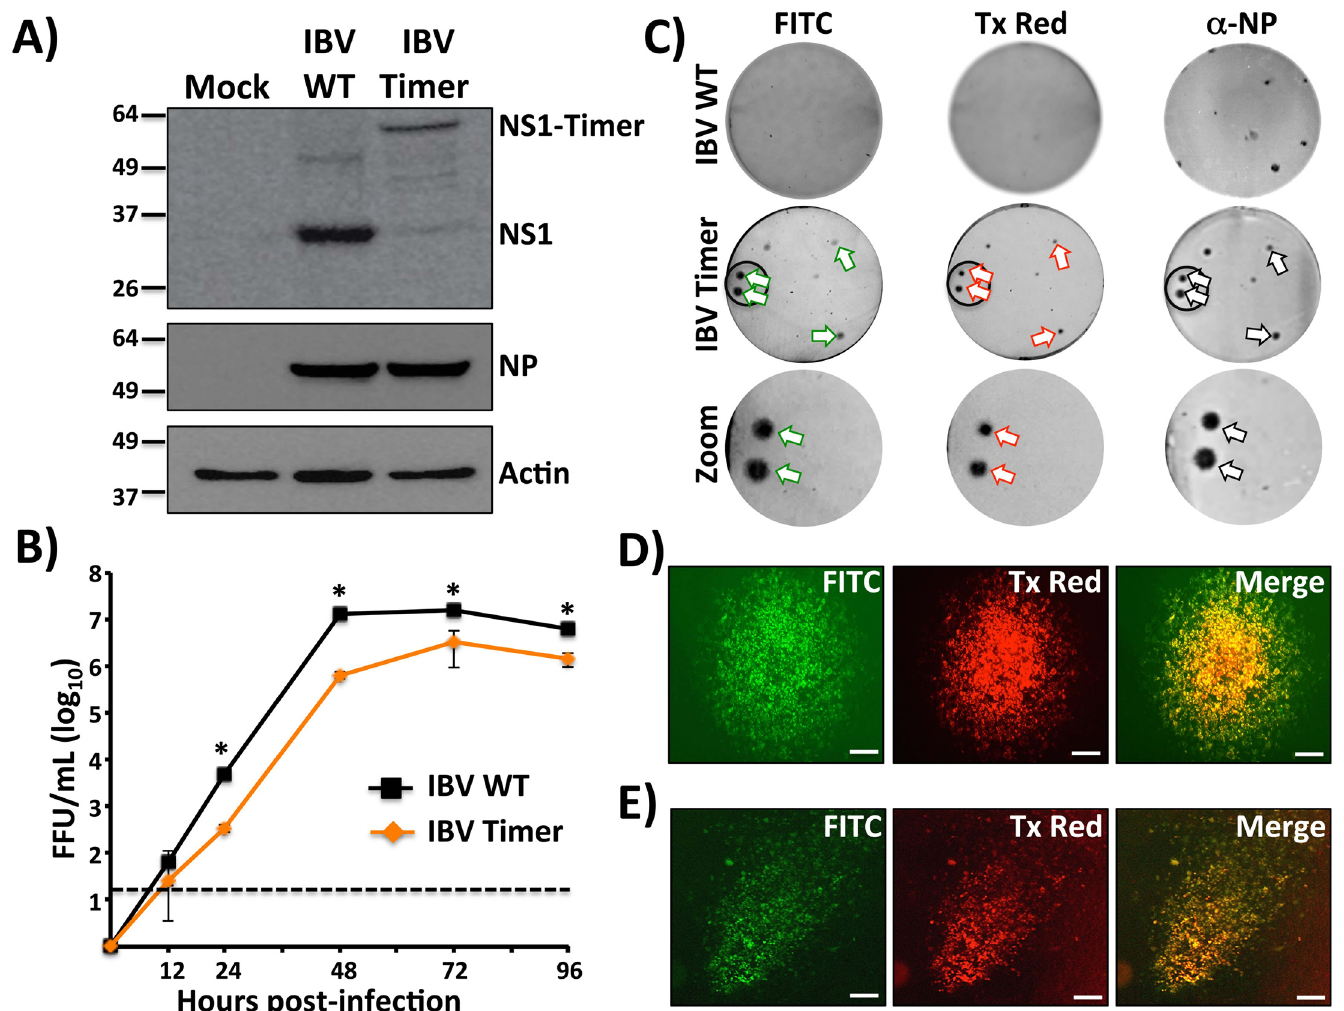
Fig 3. Characterization of IBV-Timer. A) Analysis of protein expression by Western blot: MDCK cells were mock infected or infected (MOI 3) with WT or Timer-expressing IBVs. At 24 hpi, cell extracts were prepared and analyzed for NS1 and NP expression levels using specific antibodies. Actin was used as a loading control. Numbers indicate the size of molecular markers in kDa. B) Multicycle growth kinetics: Viral titers from TCS of MDCK cells infected (MOI 0.001) with WT and Timer-expressing IBV were determined at the indicated times post-infection (0, 12, 24, 48, 72 and 96 hours) by immunofocus assay (FFU/ml). Data represent the means ± SD of the results determined from triplicates. Dotted line denotes the limit of detection (20 FFU/ml). * P < 0.05 using an unpaired two-tailed Student ’ s test. C) Plaque phenotype: Plaque sizes of WT and Timer-expressing IBVs were evaluated at 3 dpi by fluorescence using filters for fluorescein isothiocyanate (FITC) or Texas Red (Tx Red) and by immunostaining using an IBV anti-NP MAb. Arrows indicate correlation between fluorescence and the immunostaining. A zoom of the areas into the black circles for IBV-Timer is showed. “ Bull ’ s eye ” plaque (D) and “ comet tail ” (E) assays: Monolayers of MDCK cells were infected (MOI 0.001) with IBV-Timer and covered with solid (D) or liquid (E) media. At 72 hours post-infection, infected cells were visualized using filters for FITC and Tx Red. Merged images are showed. Scale bar, 200 μ m.